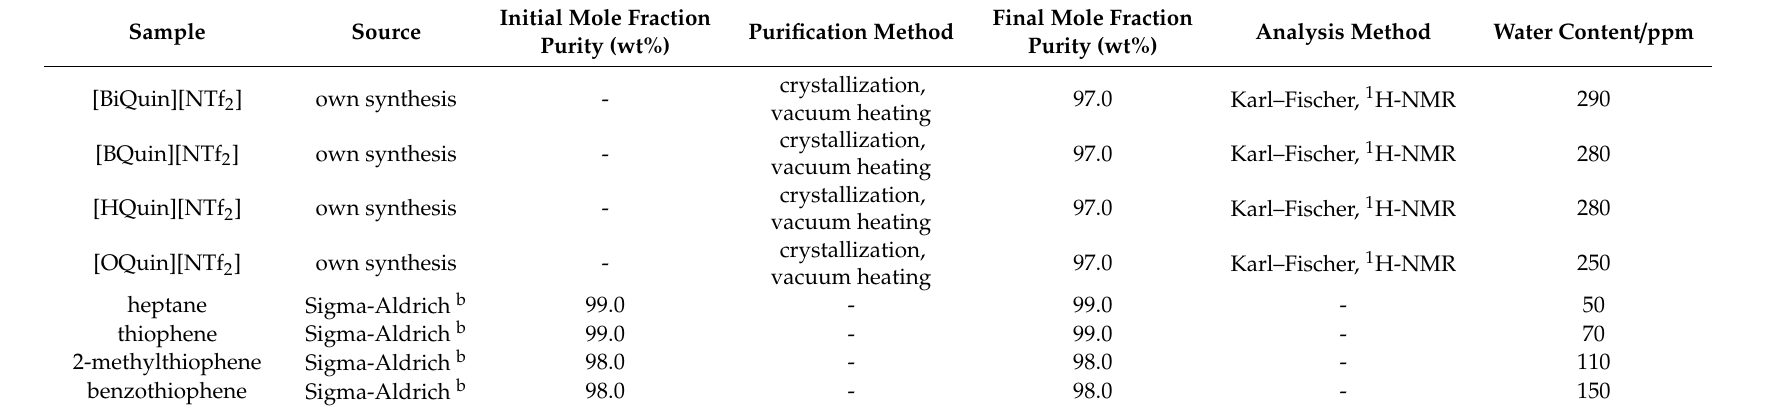
Table 7. Specifications of the chemical samples.